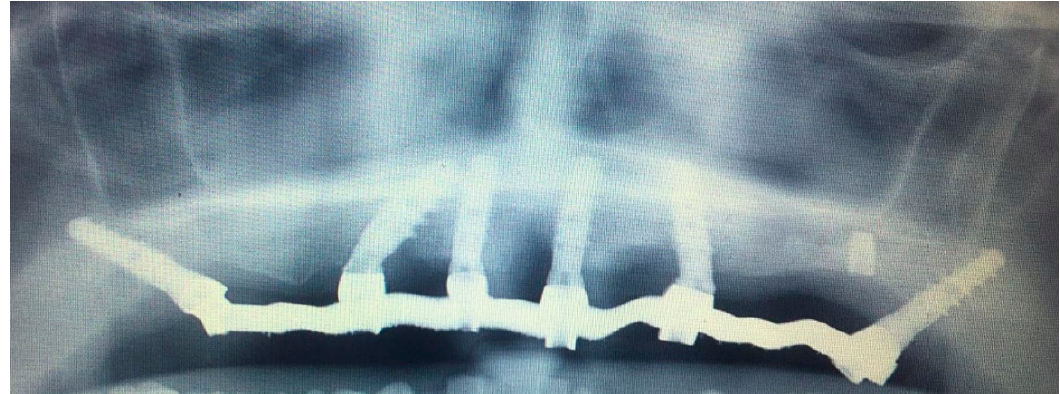
Figure 12. Final impression taken with Intra Oral Scanner (Medit i500, Seoul, South Korea) .